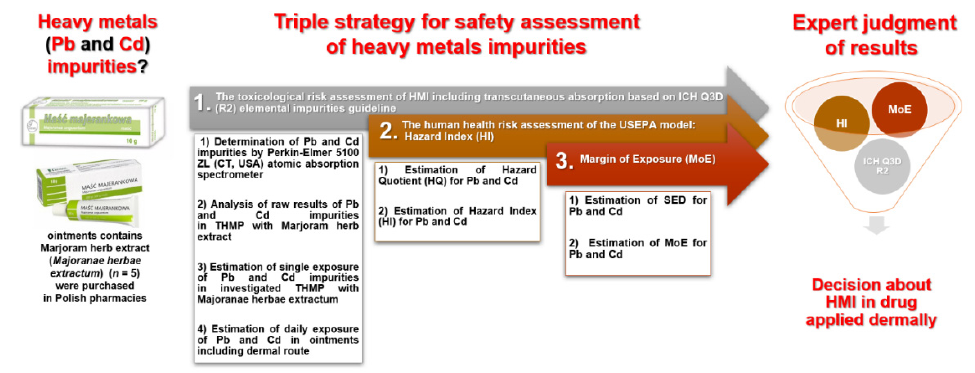
Figure 2. The applied three-stage strategy for safety assessment of HMI in ointments with marjoram herb extract ( Majoranae herbae extractum ) used adjunctively in rhinitis (runny nose) available in Polish pharmacies.